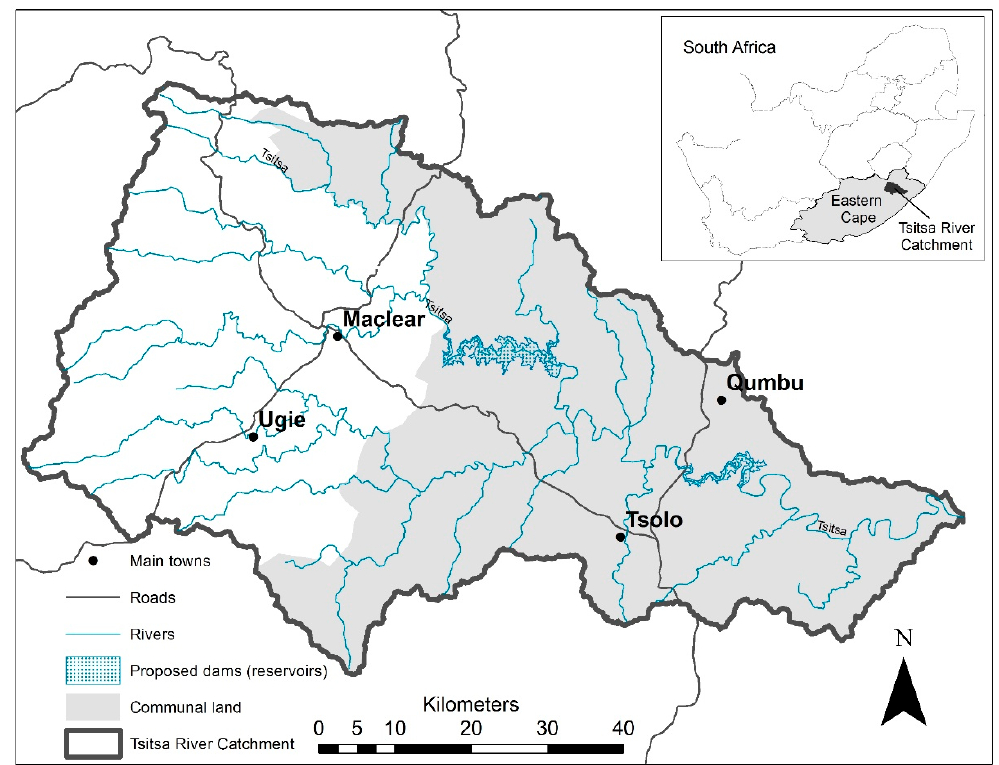
Figure 1. Location of the Tsitsa River Catchment in the Eastern Cape Province of South Africa (Map by Kyra Lunderstedt).